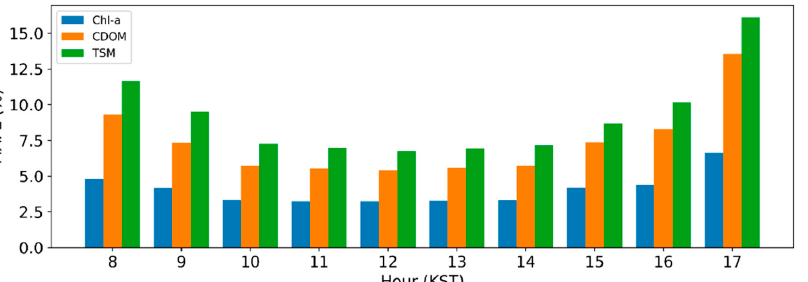
Figure 8. Hourly MAPE of ocean-color products. Blue, orange, and green bars indicate chlorophyll-a, colored dissolved organic matter, and total suspended sediment, respectively.